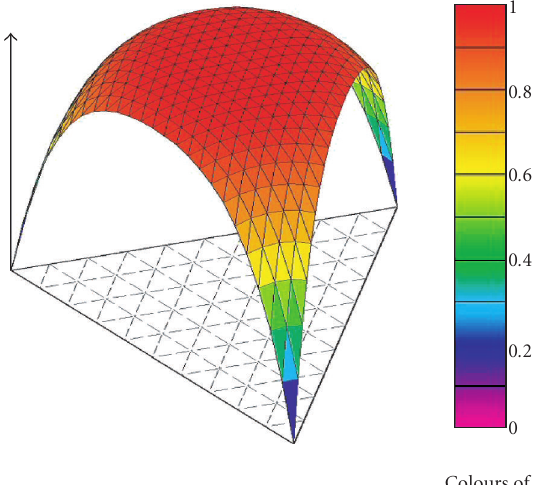
Figure 4.10. Normalised biquadratic function F 5 ( γ ) for n = 3 defined on the simplex S 2 over triangular coordinates in the